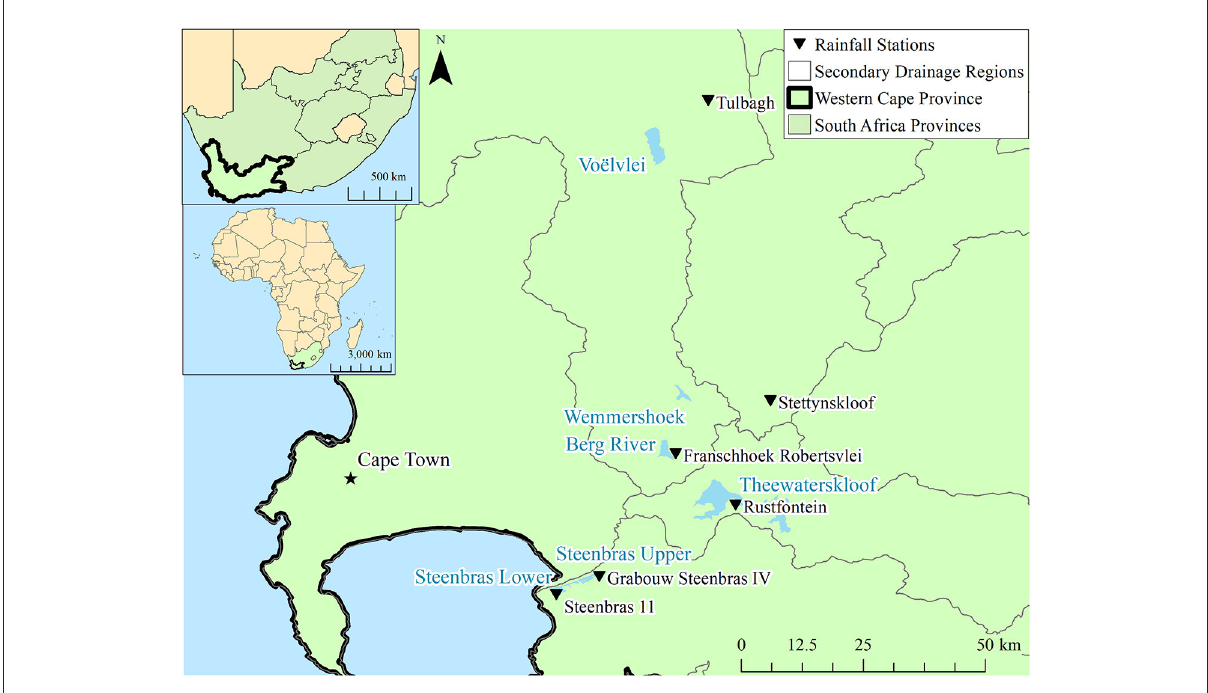
FIGURE1 Big Six dams and rainfall gauge stations in comparison to secondary catchment areas in the Western